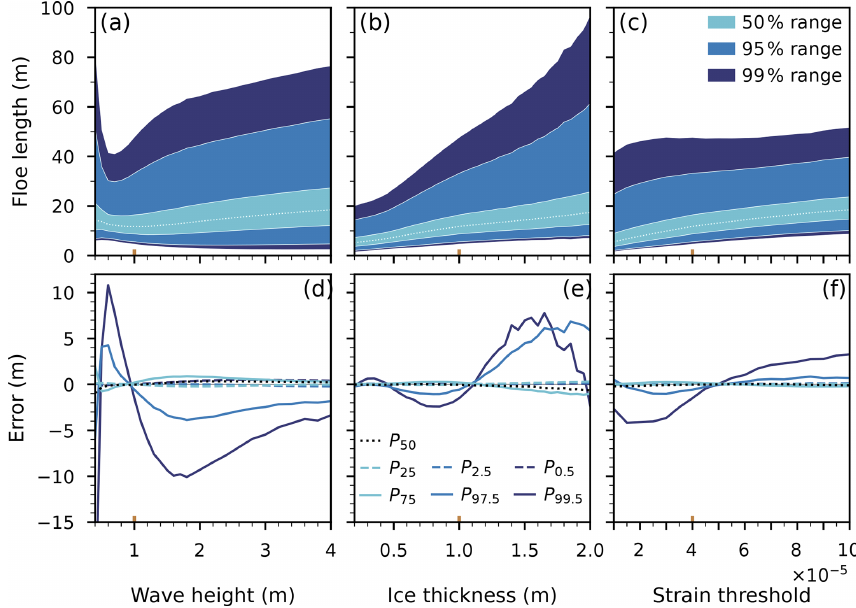
Figure 8. (a–c) Ranges of forecast distributions, generated with mean estimated parameters. The lightest-colour area in each panel is the interquartile range; the dotted line denotes the median. The colour areas are symmetrical around the median. (d–f) Errors, with respect to the experimental quantiles, in the forecast quantiles. The represented quantiles bound the colour areas in panels (a) – (c) . The 25th, 50th, and 75th percentiles are respectively the first quartile, the median, and the third quartile. Negative values suggest overprediction, while positive values suggest underprediction. The reference configuration is highlighted by coloured ticks on the horizontal